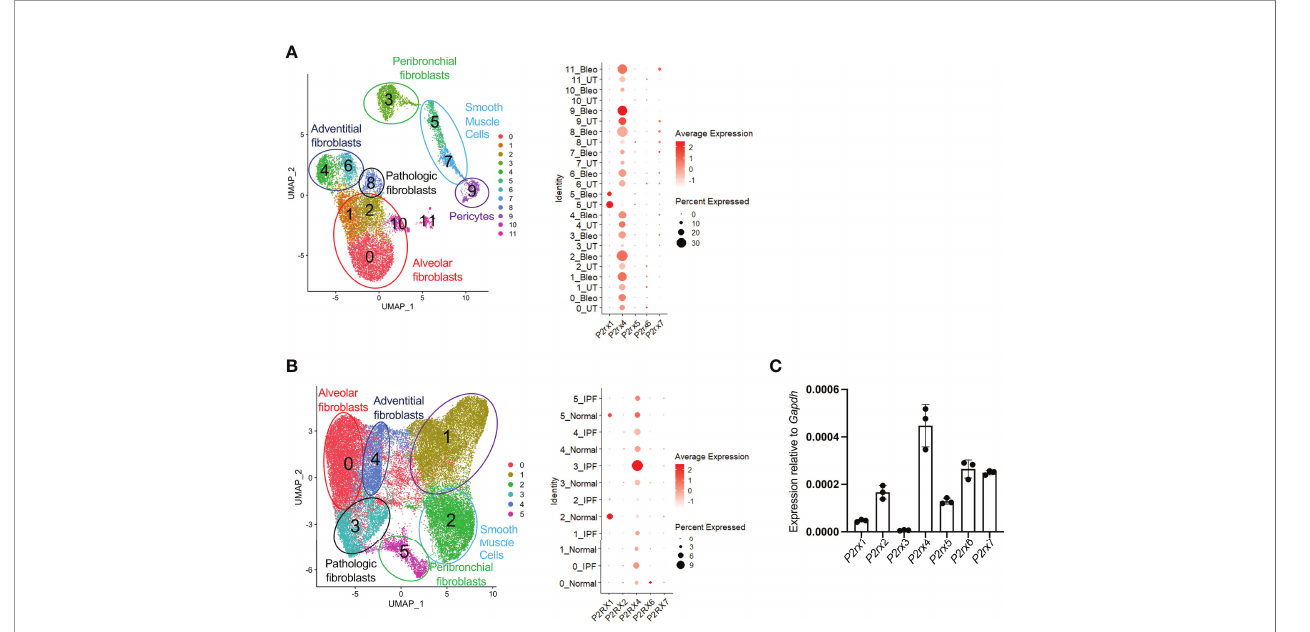
FIGURE 3 | P2rx4 is the most highly expressed ionotropic ATP receptor in lung fi broblasts. (A) UMAP plot of mouse fi broblasts from Tsukui et al. Dot plot shows expression of ionotropic ATP receptors. (B) UMAP plot of human fi broblasts from Tsukui et al. Dot plot shows expression of ionotropic ATP receptors. (C) qPCR of ionotropic ATP receptors in primary mouse lung fi broblasts isolated at steady state. N=3